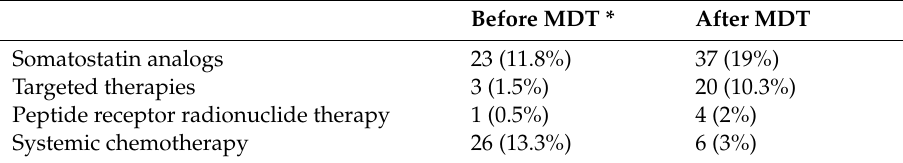
Table 2. Changes in medical treatments after first multidisciplinary